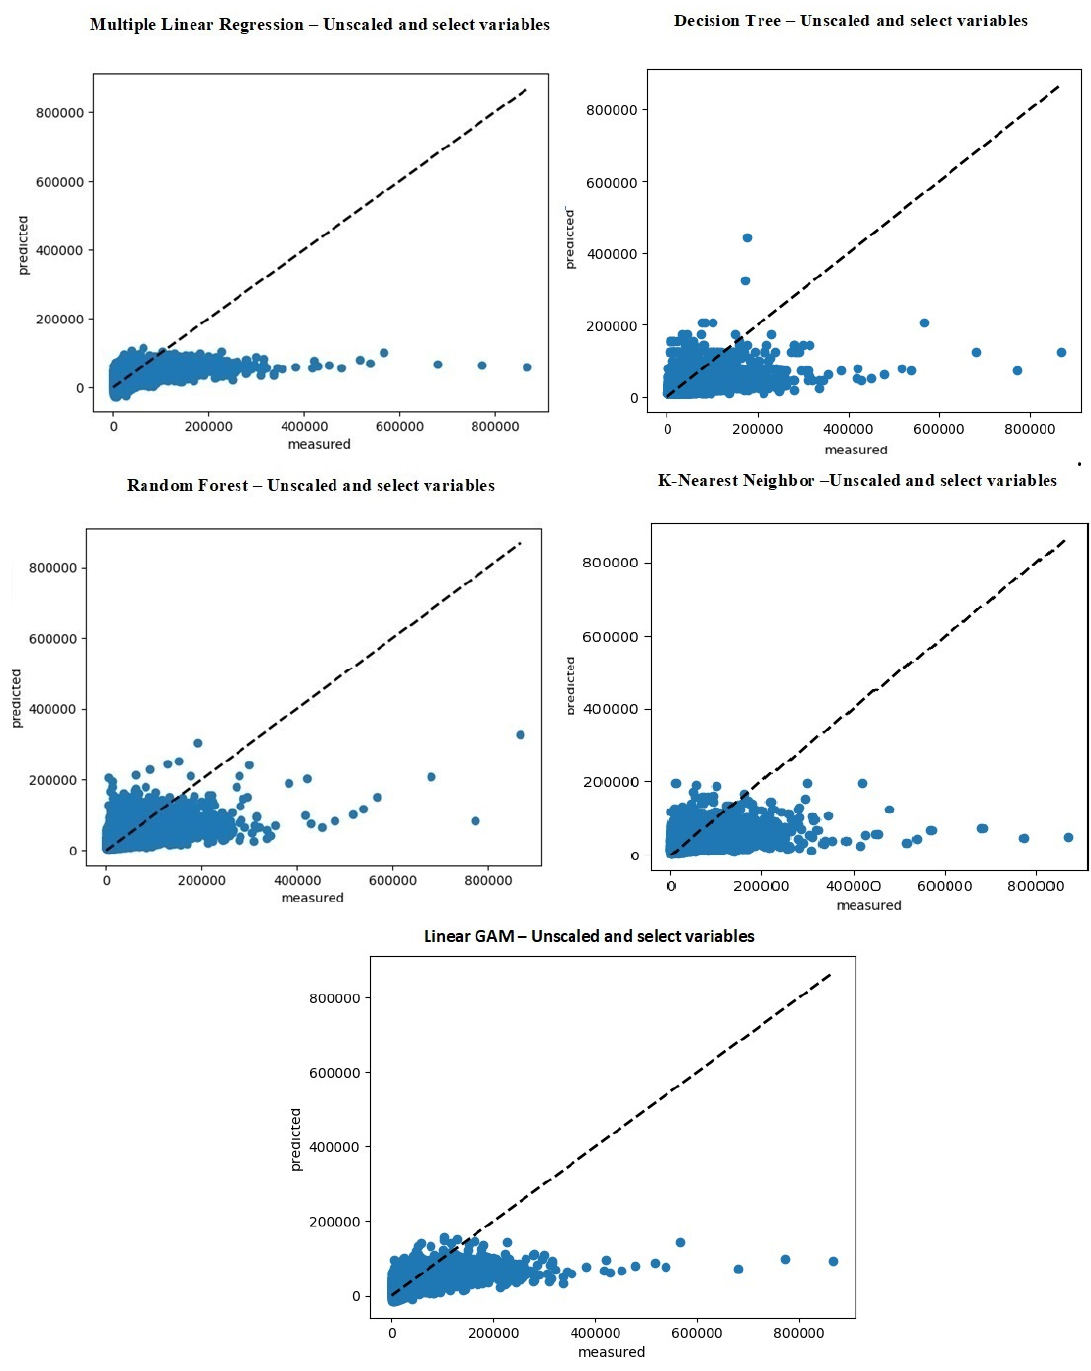
Figure 5. Performance of predicted vs. measured values for multiple linear regression, decision tree, random forest, K-nearest neighbors, and linear GAM for selected variables for test dataset.